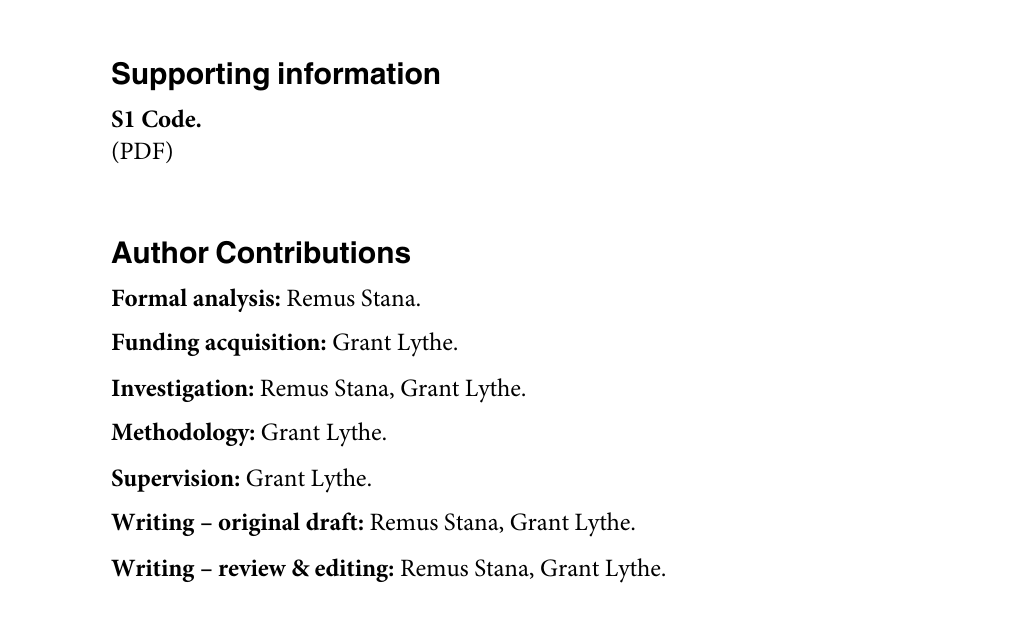
ð x ; x Þ (cid:0) G L ð x ; x ; 20 Þ . Lower left: 1 0 0 1